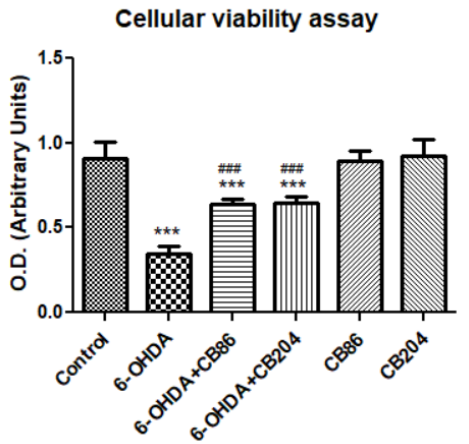
Figure 4. Cell viability assay with XTT: cell viability of PC12 was affected by the exposure of 80 µ M 6-OHDA for 24 h. When the cells exposed simultaneously to 6-OHDA with TSPO ligands CB86 or CB204 (25 µ M each) for 24 h, the rate of cell survival was increased. Results are expressed by mean ± SD ( n = 8 replicates in each group). ANOVA followed by Bonferroni’s post-hoc test was performed, F (5, 42) = 91.85, p < 0.001, *** vs. control and ### compared to 6-OHDA, p < 0.001 for all comparisons.